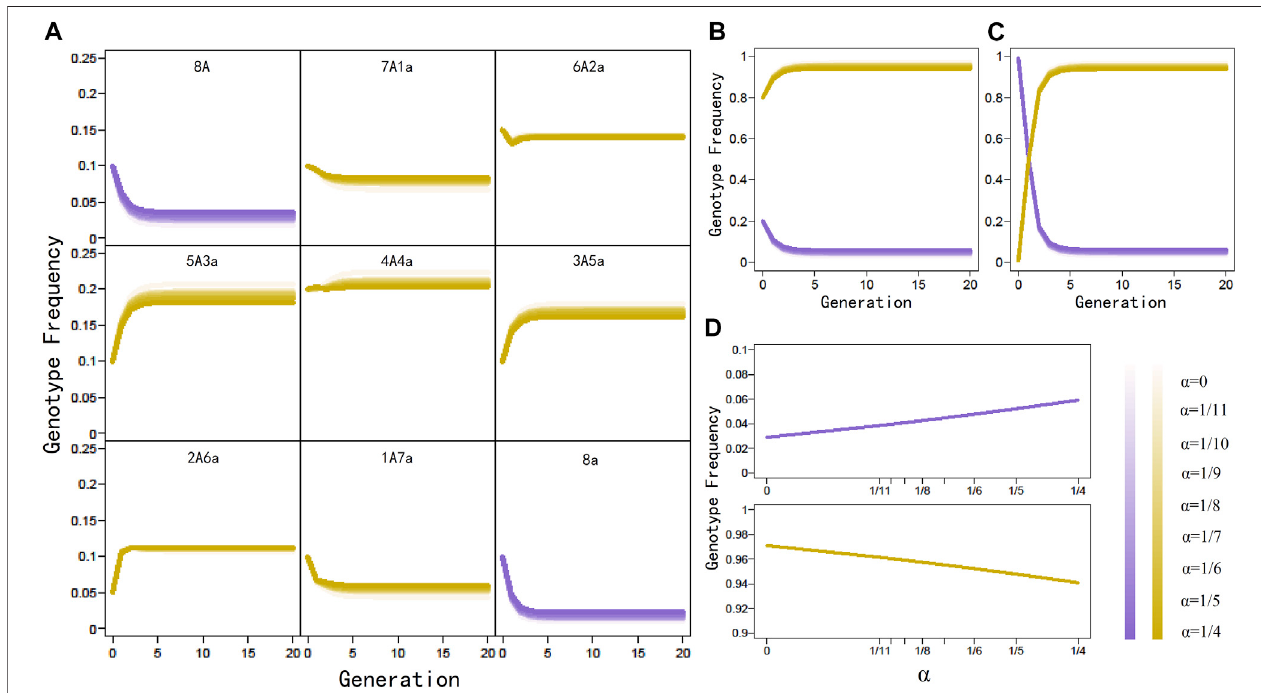
FIGURE 1 | Generation-dependent change of genotype frequencies under different levels of double reduction ( α ) in a panmictic octoploid population. (A) Change trends of individual genotype frequencies, initiated with (0.10, 0.10, 0.15, 0.10, 0.20, 0.10, 0.05, 0.10, 0.10). (B) Change trends of homozygote and heterozygote genotype frequencies derived from (A) . (C) Change trends ofhomozygoteand heterozygote genotype frequencies, initiate withextremelyhigh homozygotefrequencies (0.99) and extremely low heterozygote frequencies (0.01). (D) Equilibrium genotype frequencies of homozygote and heterozygote change as a function of α . Legends of α are indicated by color